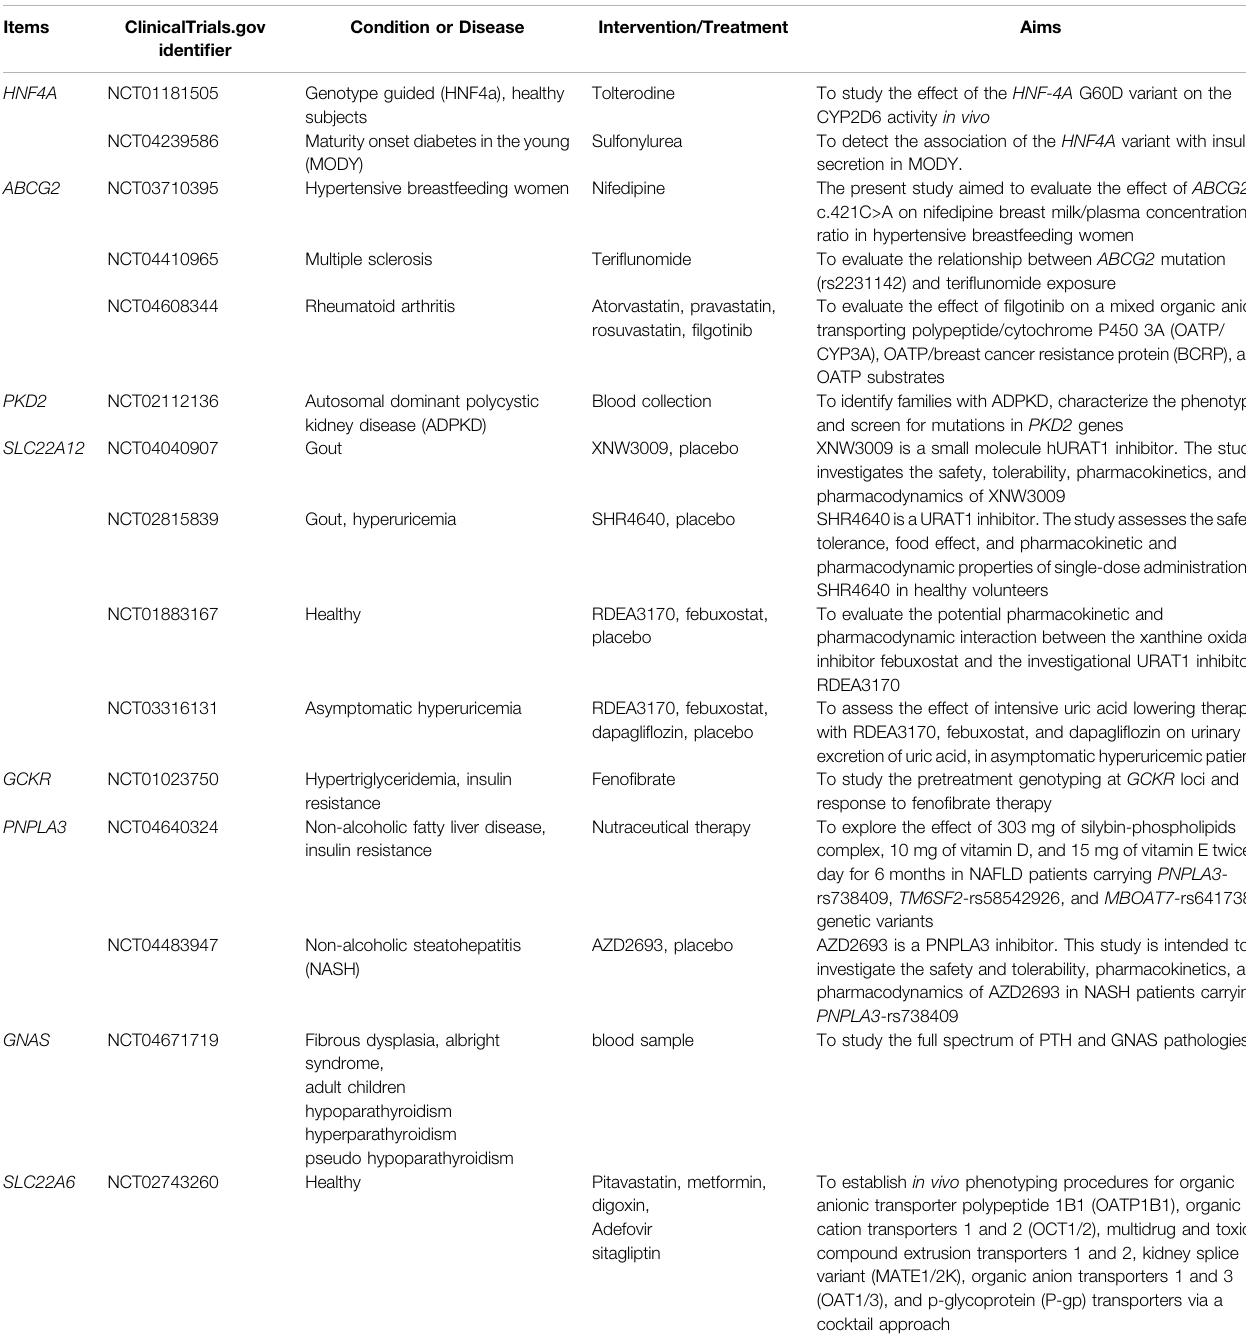
TABLE 2 | Gene tests in clinical trials.